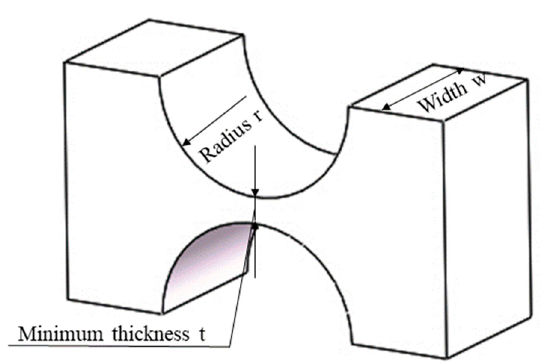
Figure 2. Straight round flexure hinge. Table 1. Performance parameters of P-820.2B stacked piezoelectric ceramic actuator.